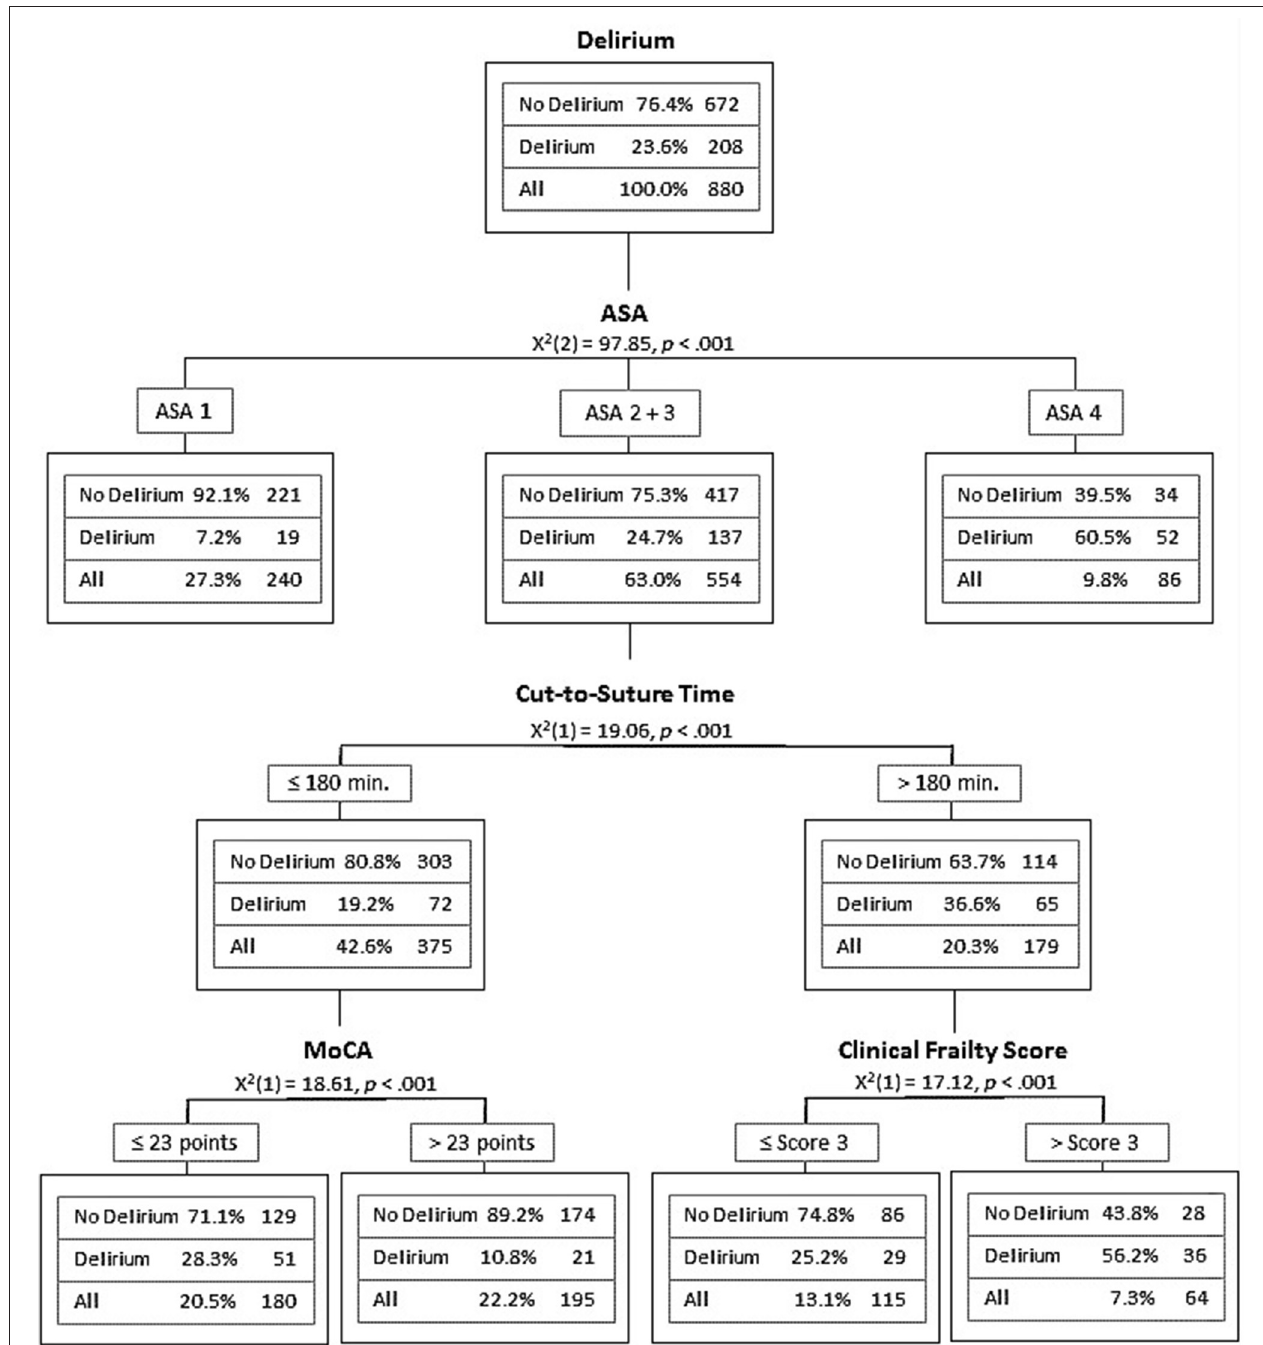
FIGURE 3 | Classification tree showing the CHAID analysis of the final